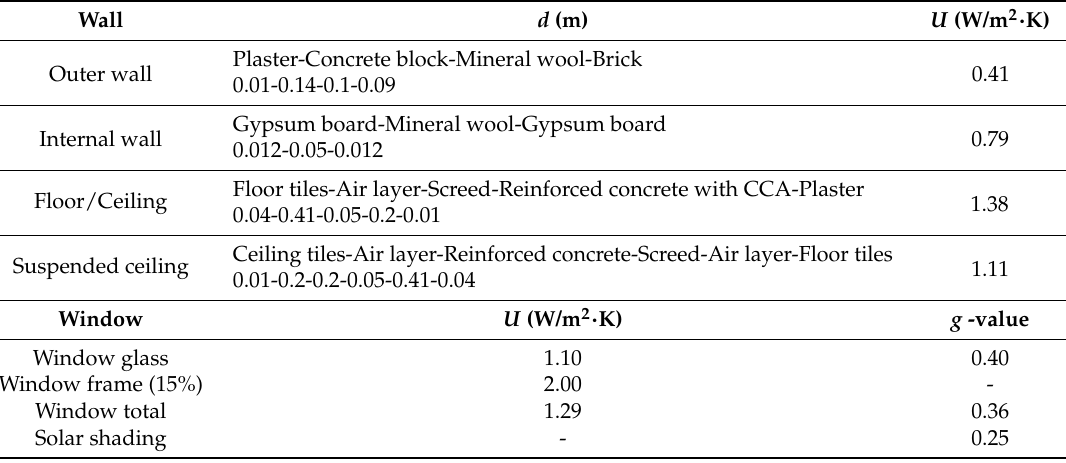
Table 1. Technical characteristics of wall layouts and windows.